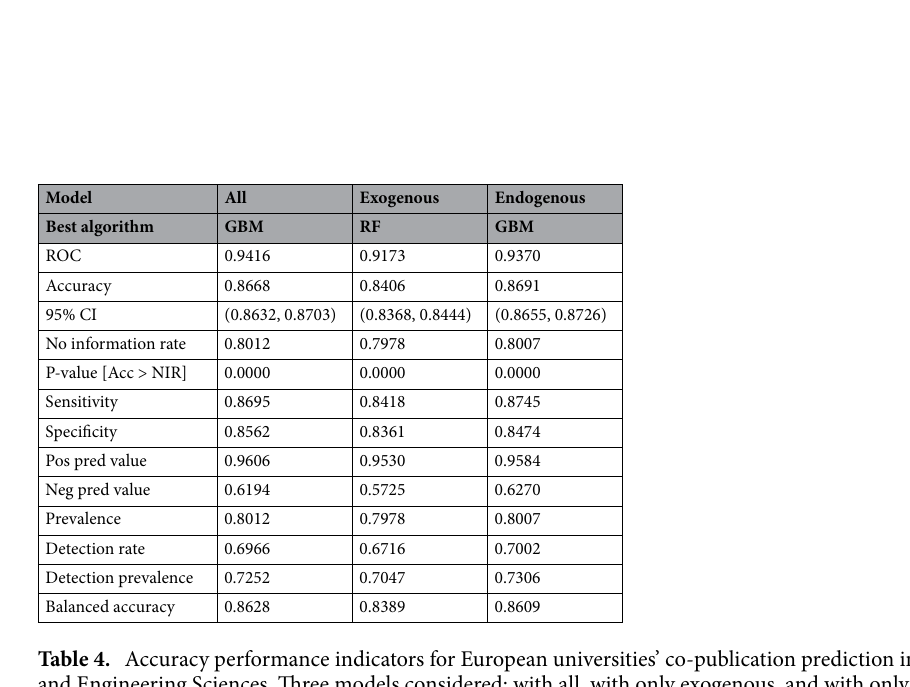
Figure 3. Precision–recall curves for European universities’ co-publication prediction in the Physical and Engineering Sciences. Three models considered: with all, with only exogenous, and with only endogenous features.